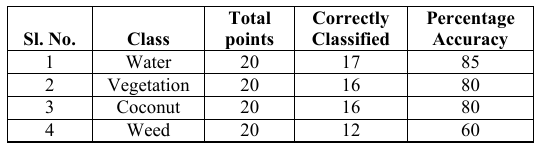
Table 3: Agricultural Features Accuracy using FSO